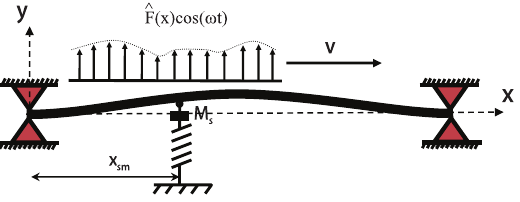
Fig. 1. Schematic representation of an axially moving beam with an intermediate spring-mass support subjected to a thermal